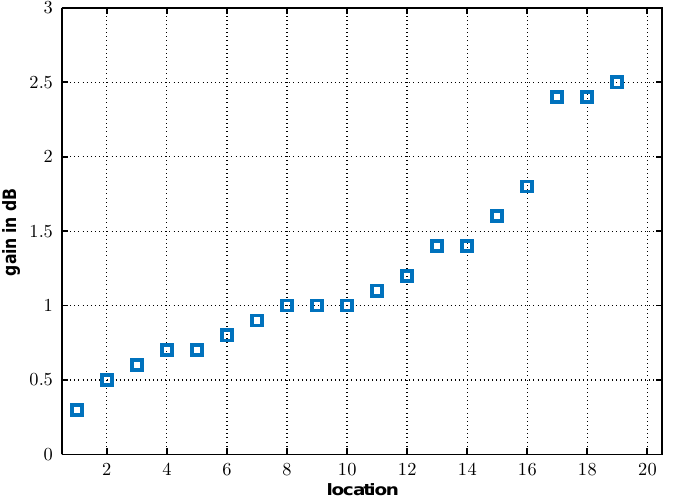
Figure 14. Gain achieved by the equal-gain diversity wake-up receiver system over the selection diversity wake-up system for the 20 locations in ascending